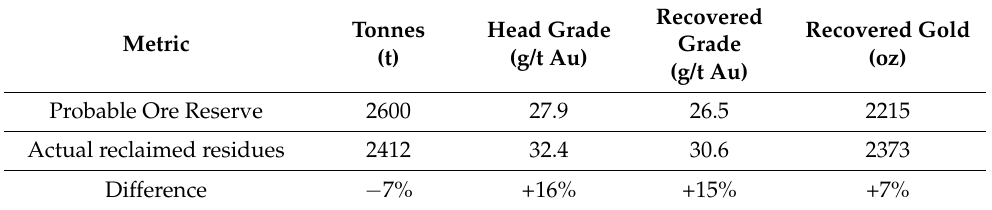
Table 13. Reconciliation between the actual extracted and the residues of the ore reserve for the South Vein area. Ore reserve head grade based on grade control drilling. Actual reclaimed residues based on reconciliation of gold produced from pilot plant and tailings samples. Figures may not compute due to rounding.